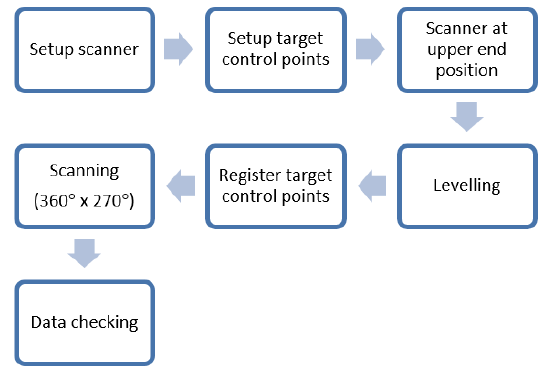
Figure 4: The procedure of data scanning